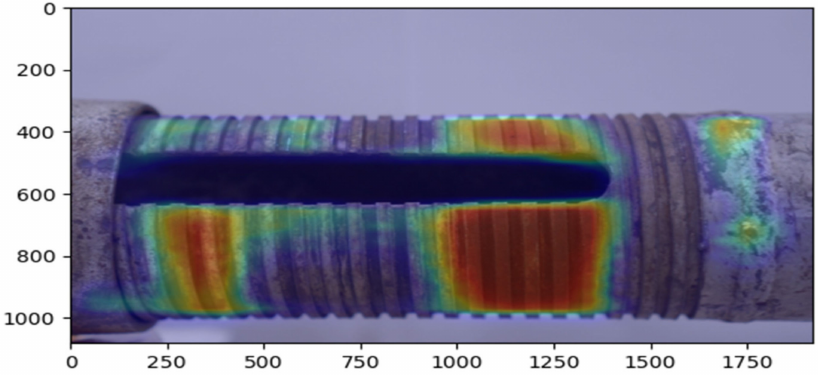
Figure 7. The predicted heat map of the deformation